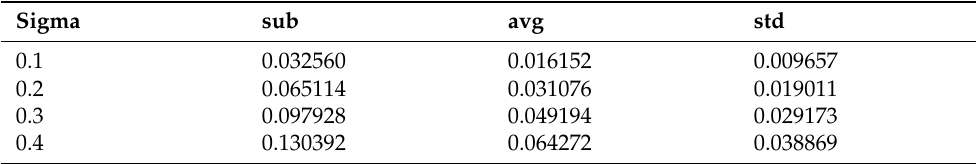
Table 2. Relate error results under different sigma on real